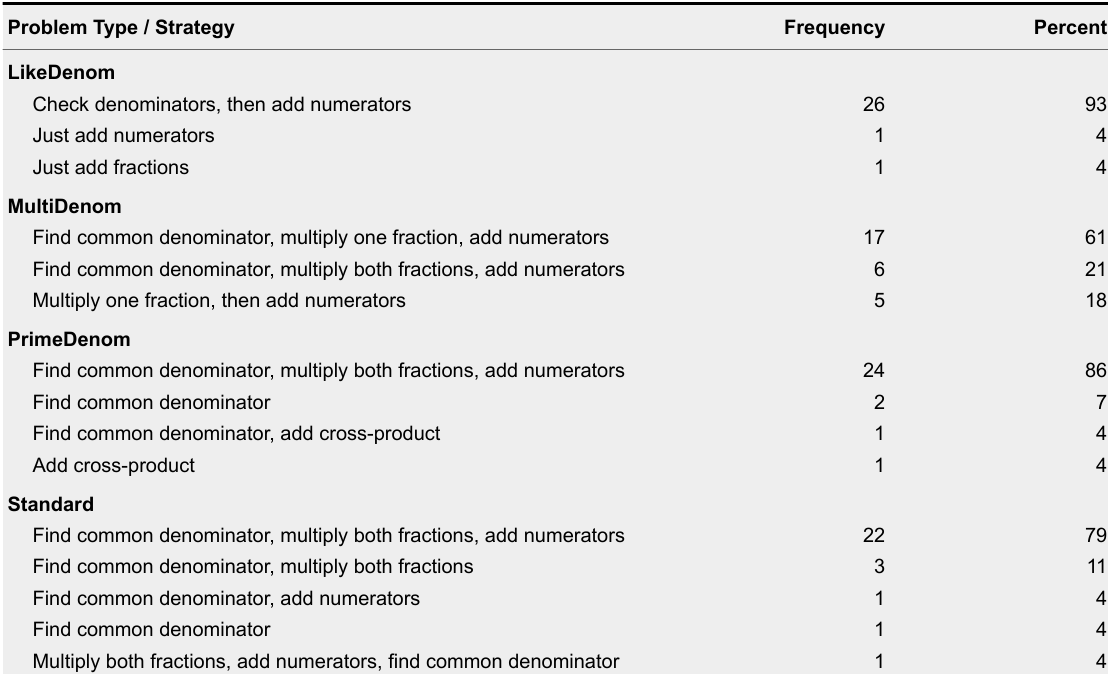
Self-Reported Strategies per Problem